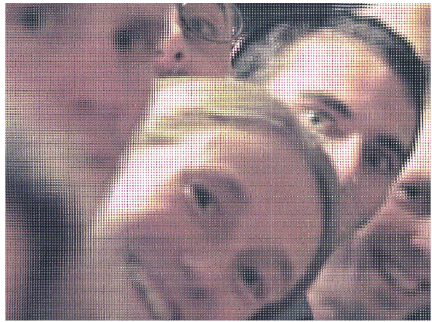
Figure 12: Lightfield of 160 × 120 × 15 × 15 used for performance testing.